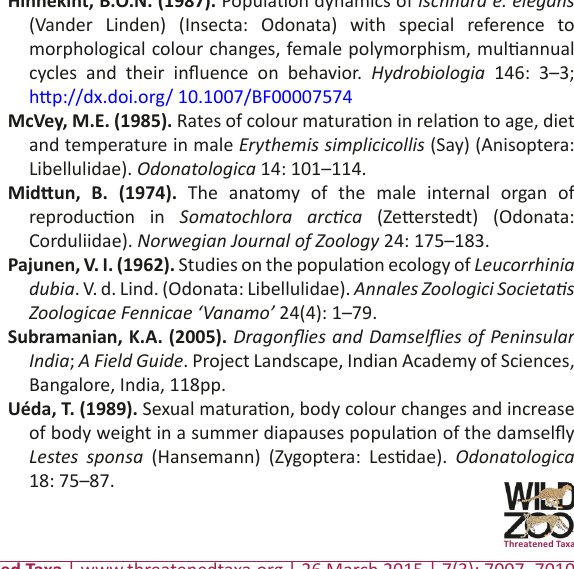
Reddish-brown Blackish-brown Brown Reddish-ochreous Blackish-brown Brown Reddish-ochreous Blackish-brown Brown Scarlet red Blackish-brown Brown Scarlet red Crest yellow Yellow Scarlet red Yellow Yellow Brown Reddish brown Dark brown Bright scarlet Olivaceous Olivaceous Dark brown with citron yellow mid dorsal Brown with citron yellow mid dorsal stripe. Reddish-brown without any markings. stripe. Golden brown laterally, blackish-brown Brown laterally and dorsally with a bright dorsally with a bright yellow citron stripe. yellow citron stripe. Dark golden brown, with a bright light yellow Golden brown, with a bright light yellow Brilliant scarlet red. strip on mid dorsum of segments 1–4. strip on mid dorsum of segments 1–4. Red, projecting and rounded at apex. Absent Brown, projecting and rounded at apex. Present (Image 2a,c) Golden brown, depressed arched. Golden brown, small with a narrow base and angled out. Red, straight, projecting out. Golden brown, straight, projecting out. Bright red narrow and rounded. Golden brown, narrow and rounded. Dark red with a black tip. Brown with a black tip. Golden yellow, long, straight and spiny Brownish yellow, short conical. beneath (Image 2b). Golden yellow, short obtuse at apex (Image Brilliant scarlet red, short obtuse at apex. Absent